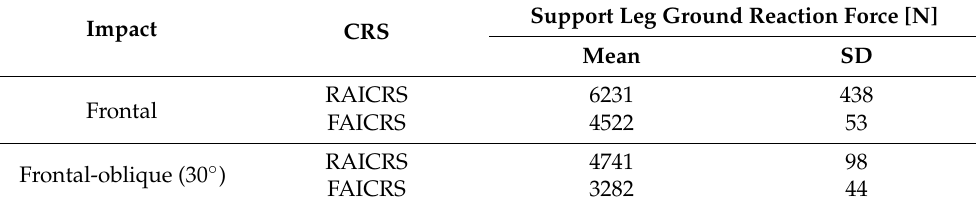
Table 4. Support leg ground reaction forces.